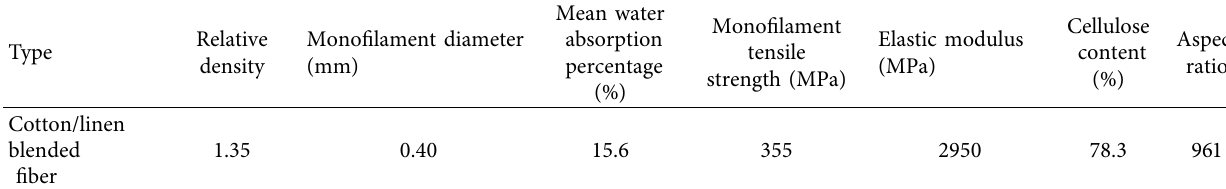
Table 4: Basic physical parameters of cotton/linen blended